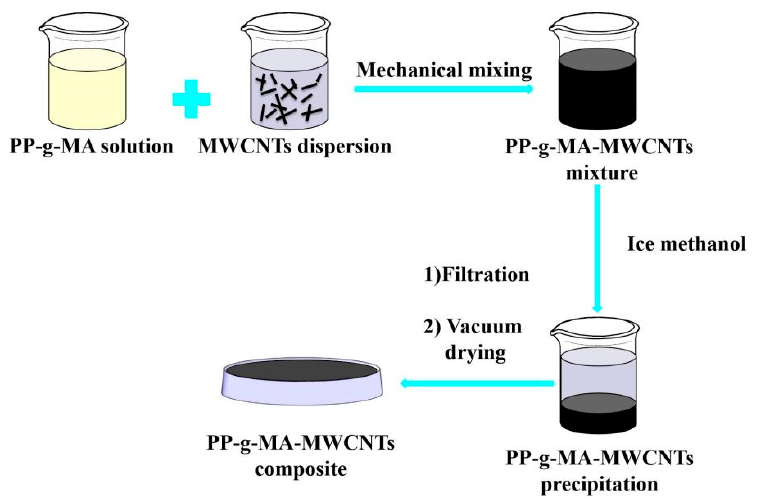
Figure 1. Preparation process.